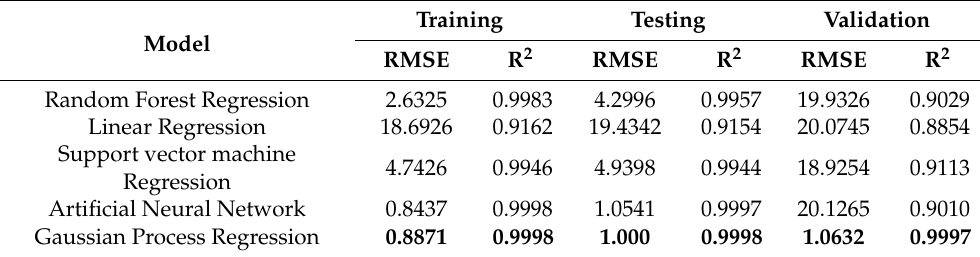
Table 3. Sensitivity analysis of developed machine learning models.